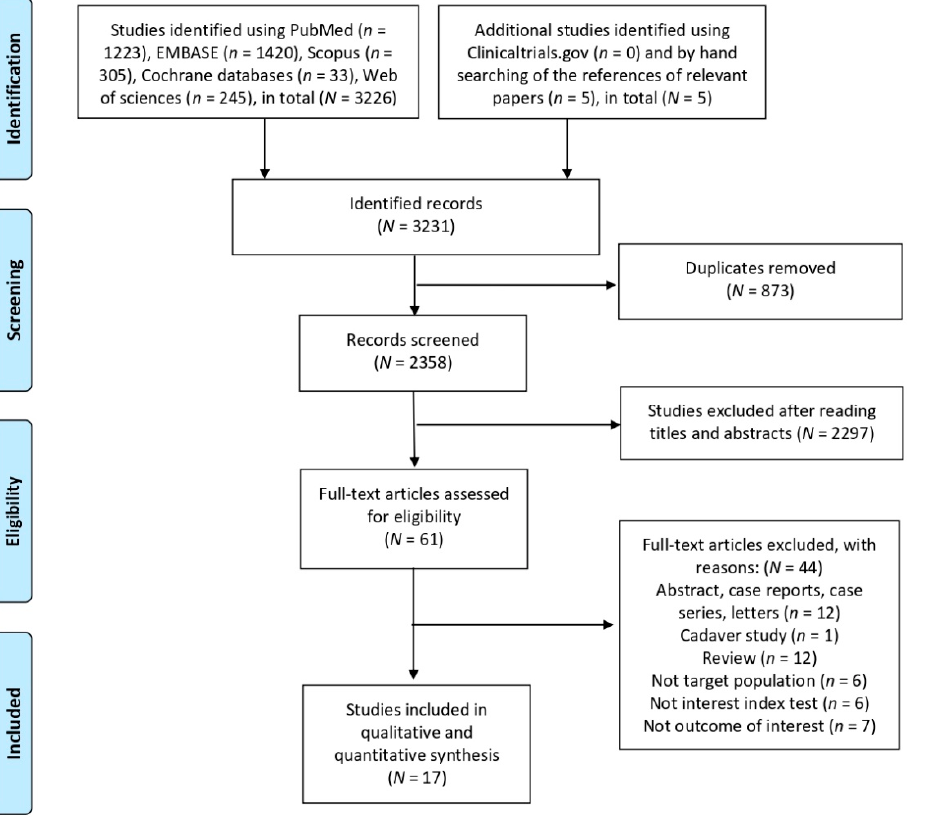
Figure 1. Flowchart of study selection for the current meta-analysis.